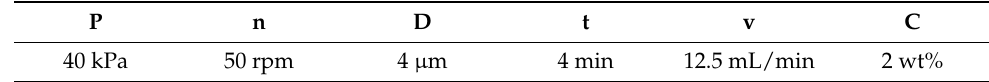
Table 2. Ultrasonic-assisted lapping